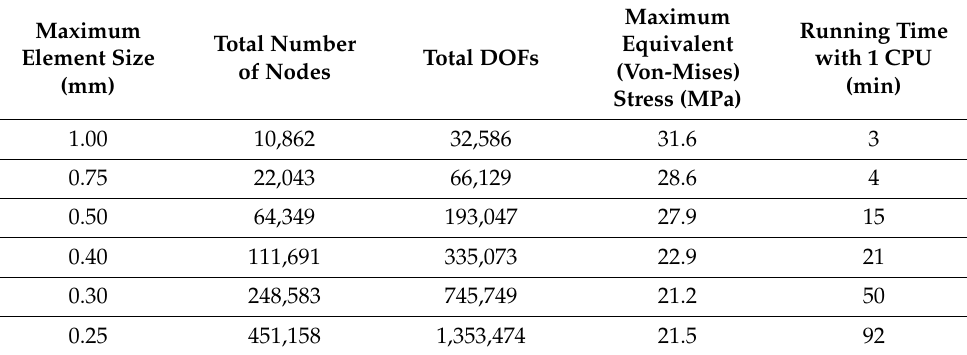
Table 3. Mesh convergence test for macroscale